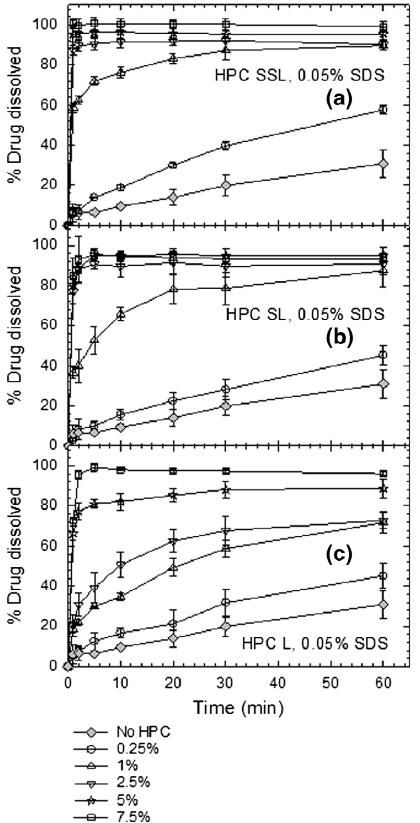
Figure 9. Drug (GF) release profiles of the nanocomposites prepared using wet-milled GF suspensions containing 0.05% SDS and HPC with different molecular weights of HPC: ( a ) HPC SSL (40 kDa); ( b ) HPC SL (100 kDa); and ( c ) HPC L (140 kDa) (Adapted from Li et al. [86] with permission from Elsevier, www.elsevier.com).